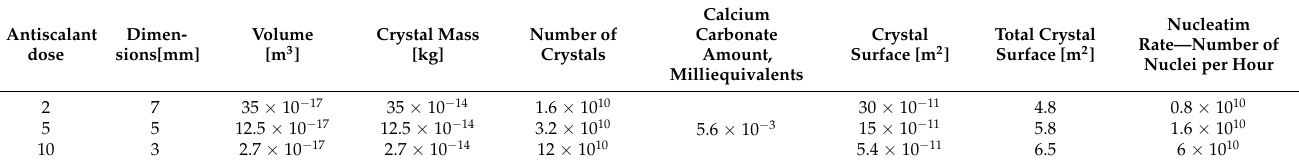
Table 2. Main characteristics of crystal